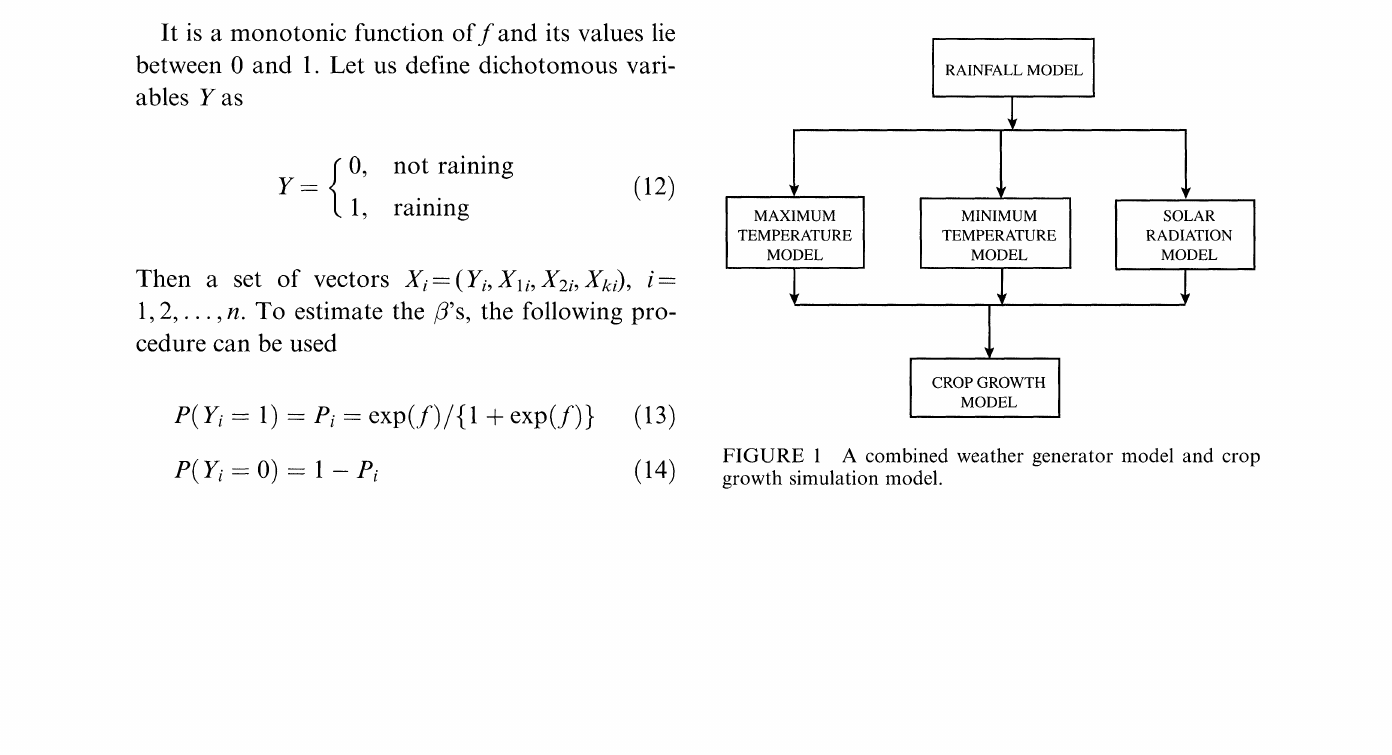
A combined weather generator model and crop growth simulation